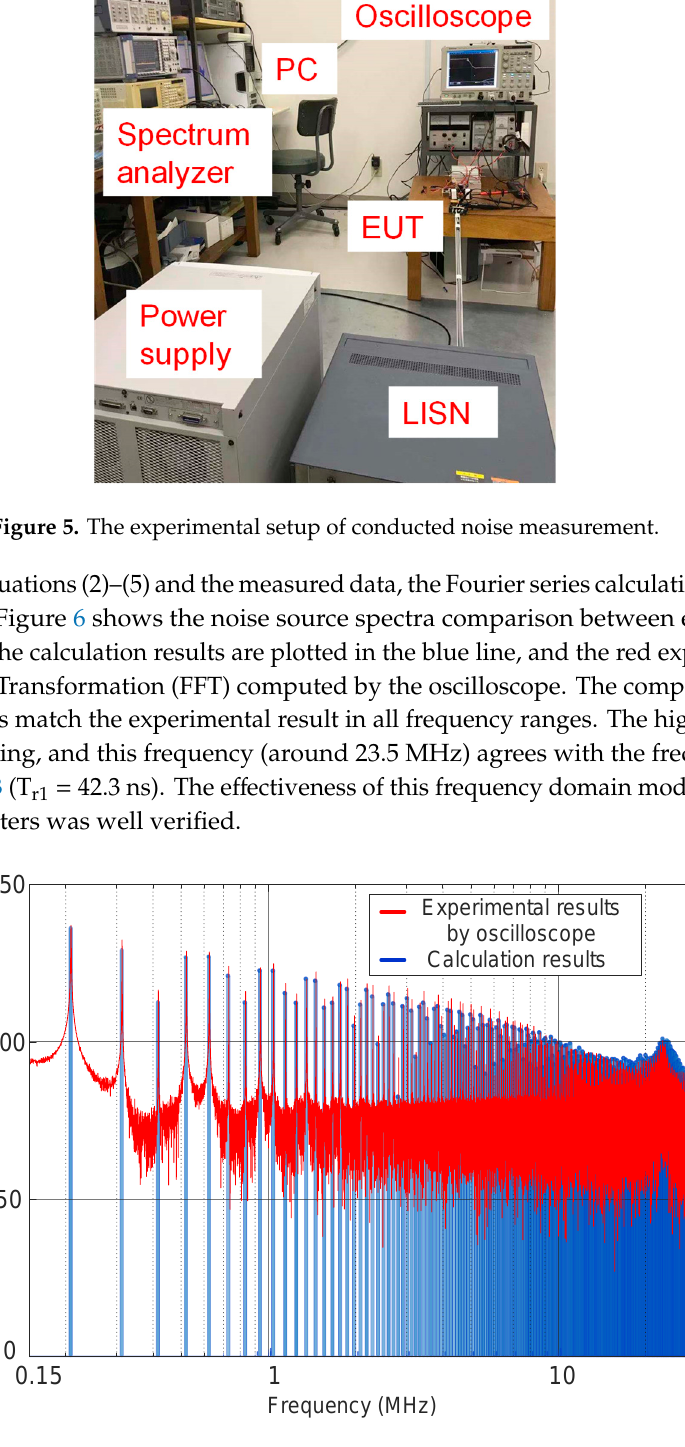
Figure 6. The frequency spectra of switch voltage (noise source) comparison between calculation and measured results.